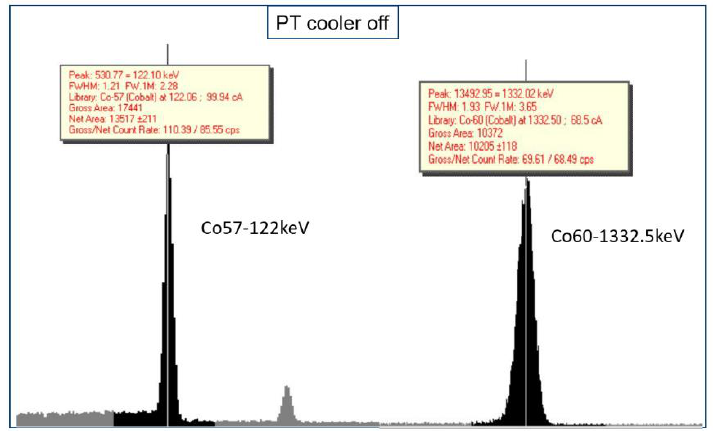
Figure 10. Co60 and Co57 energy resolution with PTC switched off. Table 5. Heat links isolation performance measurement